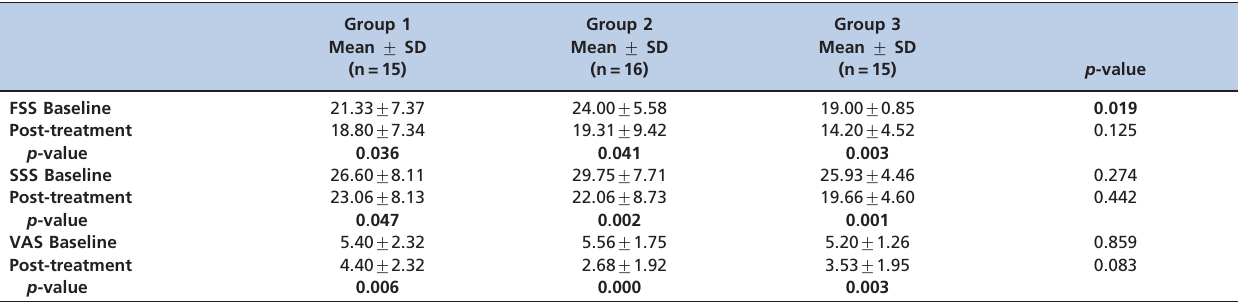
Table 2 - Comparison of the clinical parameters at baseline and at the end of treatment (post-treatment).